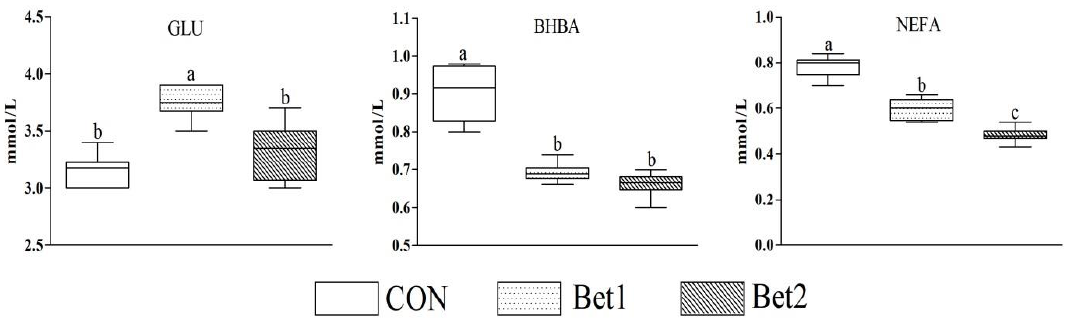
Figure 1. E ff ects of Bet on the serum GLU, NEFA, and BHBA parameters of dairy cows. GLU = glucose; Figure 1. Effects of Bet on the serum GLU, NEFA, and BHBA parameters of dairy cows. GLU = NEFA = non-esterified fatty acid; BHBA = β -hydroxybutyric glucose; NEFA = non-esterified fatty acid; BHBA = β-hydroxybutyric acid.